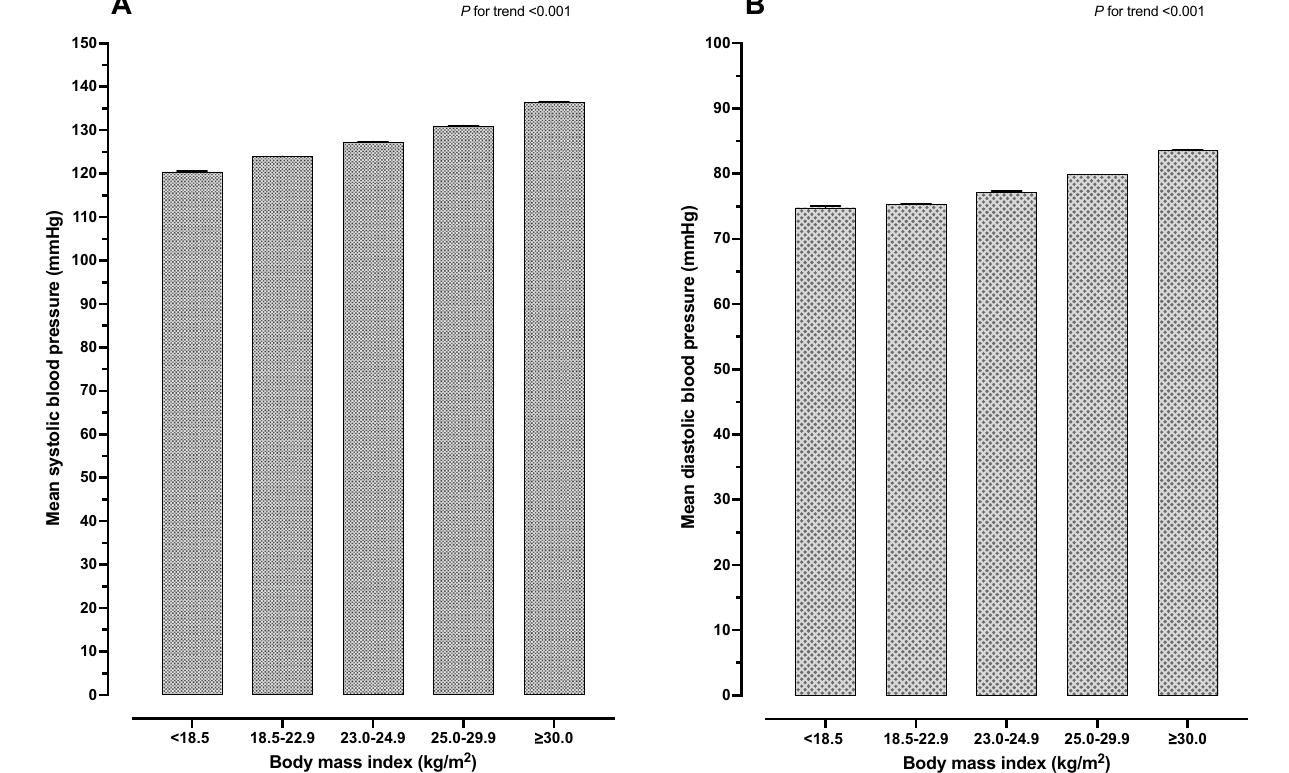
Figure 3. Average adjusted prediction of mean blood pressure (mmHg) and 95% CI, by body mass index categories. ( A ) Average adjusted prediction of mean systolic blood pressure among overall RTA personnel, adjusting for age, sex, regions, health insurance scheme, a history of diabetes, smoking status, alcohol use, exercise, and years. ( B ) Average adjusted prediction of mean diastolic blood pressure among overall RTA personnel, adjusting for age, sex, regions, health insurance scheme, a history of diabetes, smoking status, alcohol use, exercise, and